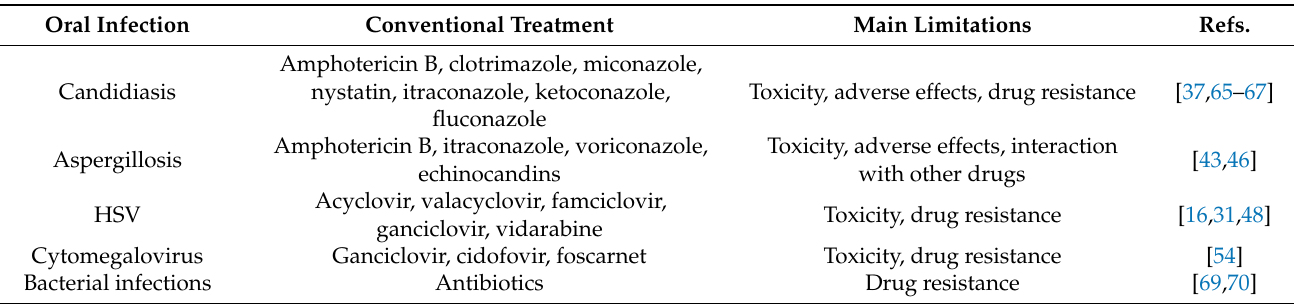
Table 1. The most commonly used synthetic antimicrobial drugs for treating oral infections. Oral Infection Conventional Treatment Main Limitations